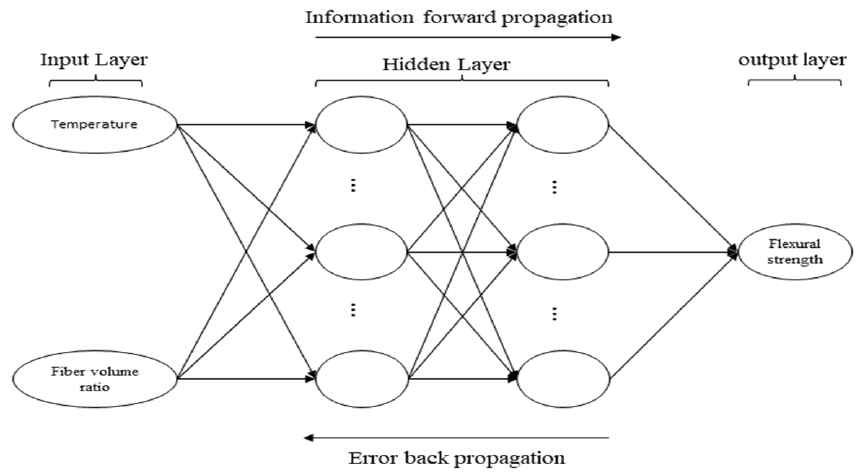
Figure 8. Topological structure of BP neural network.